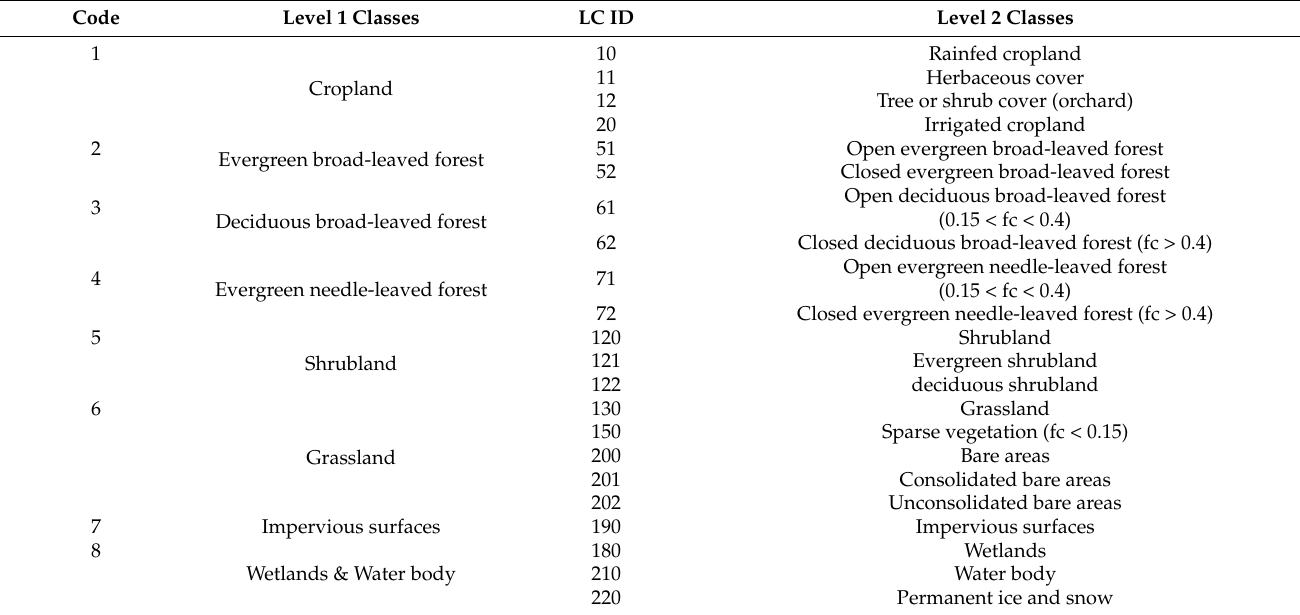
Table 2. LULC classification system in